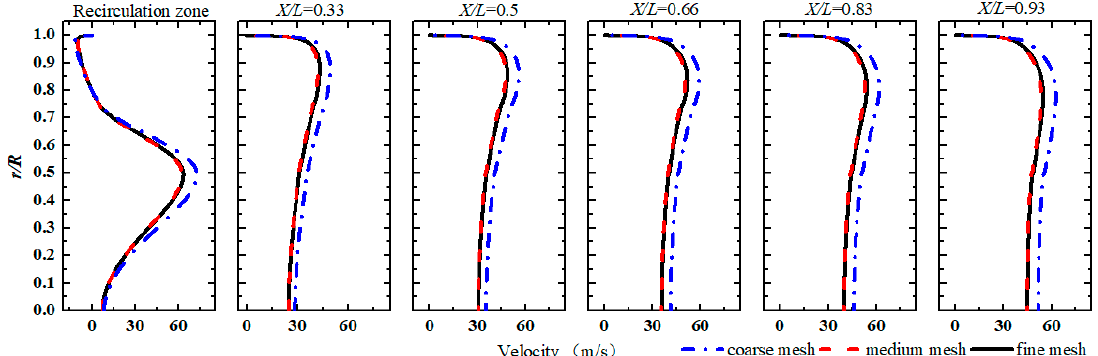
Energies 2019 , 12 , x FOR PEER REVIEW Figure 6. Axial velocity in di ff erent axial locations for di ff erent mesh number.